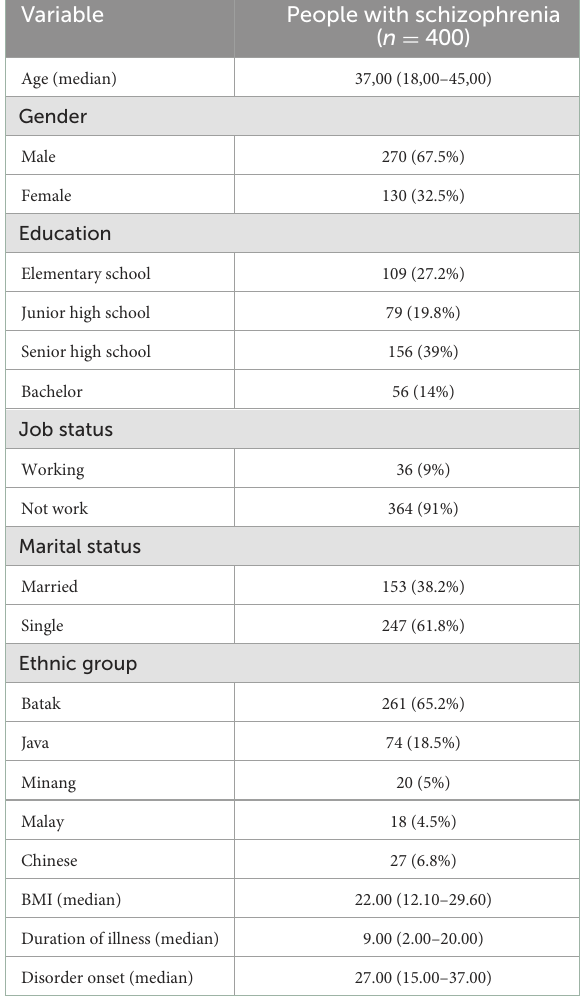
TABLE 1 Demographic